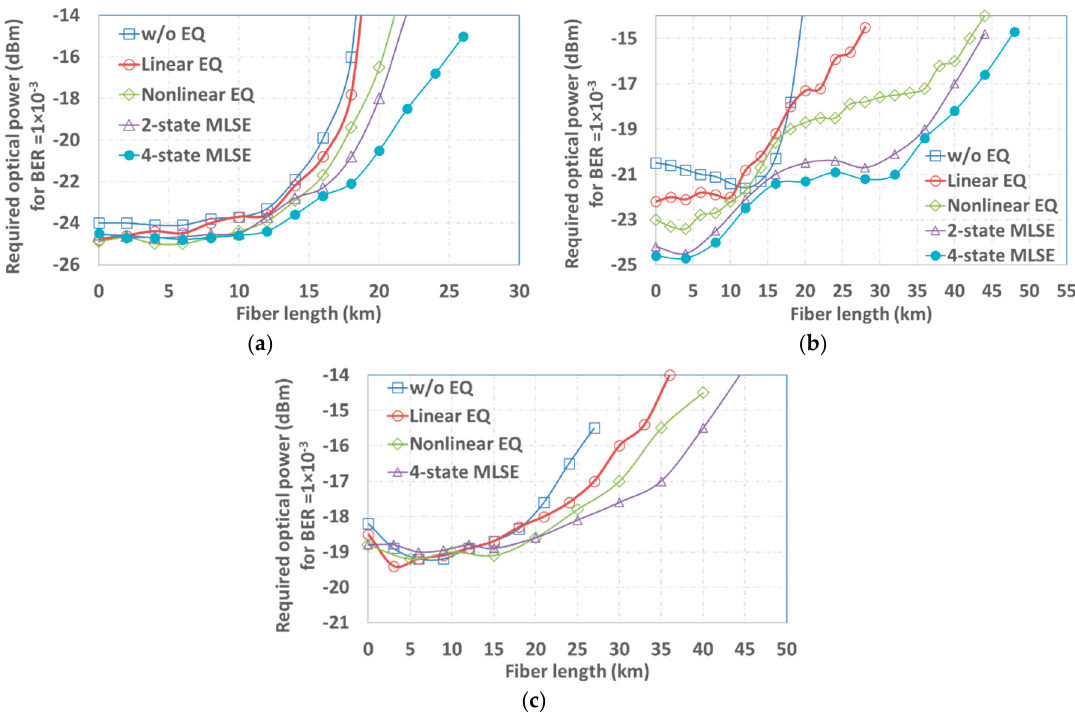
Figure 4. Optical power sensitivity at a bit error rate (BER) of 10-3 versus fiber lengths for ( a ) optical Duobinary; ( b ) electrical Duobinary; and ( c ) PAM-4 subject to different post-equalization and detection conditions. For receiver digital signal processing (DSP), the following configurations are considered: without equalization (w/o EQ) where no DSP considered; linear EQ, which uses only 7-tap/5-tap linear FFE/DFE; nonlinear EQ includes both linear FFE/DFE terms and second-order nonlinear FFE/DFE terms; maximum likelihood sequence estimation (MLSE) contains linear and nonlinear EQ, as well as 2- or 4-state MLSE. Unless indicated explicitly, the four DSP configurations apply throughout this work.